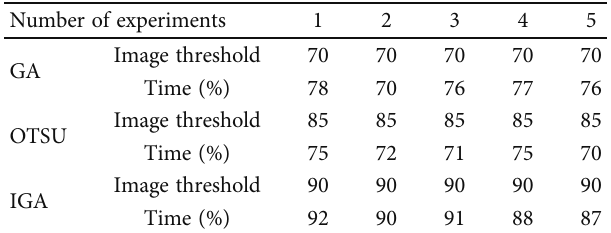
Table 2: E ffi ciency of three algorithms for segmenting